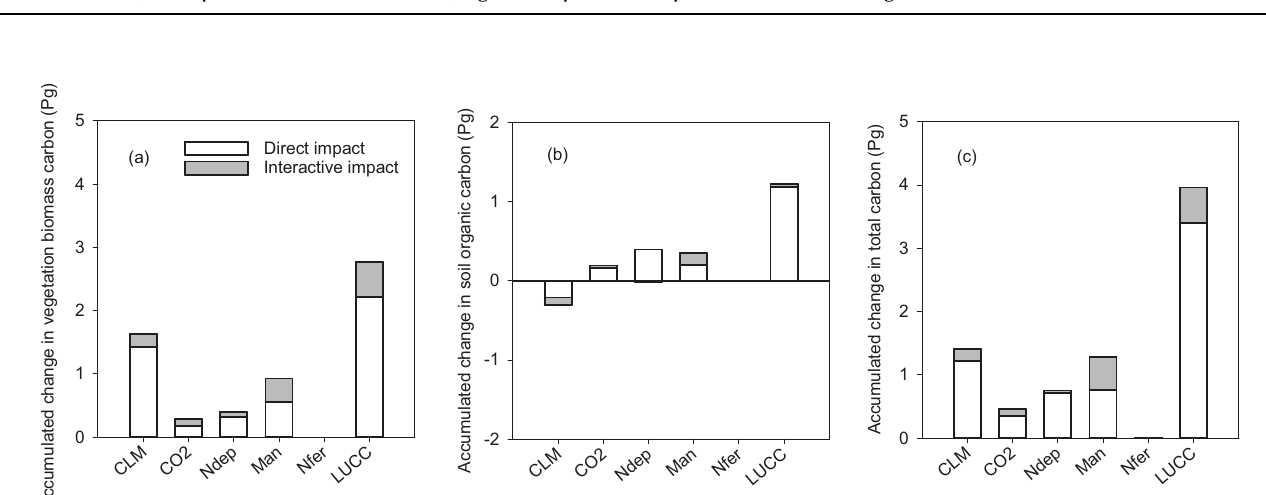
values indicate sink and source, respectively; green and yellow bar stacked in the insertindicateLUCCimpactsonvegetationand soilorganiccarboninPgC;spatial map unit: gCm − 2 ; error bars: one standard deviation from the mean of LUCC impacts on total carbon storage.